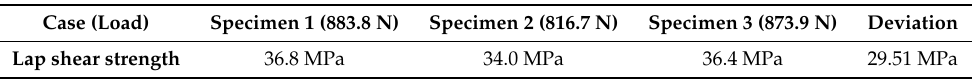
Table 3. Tensile test